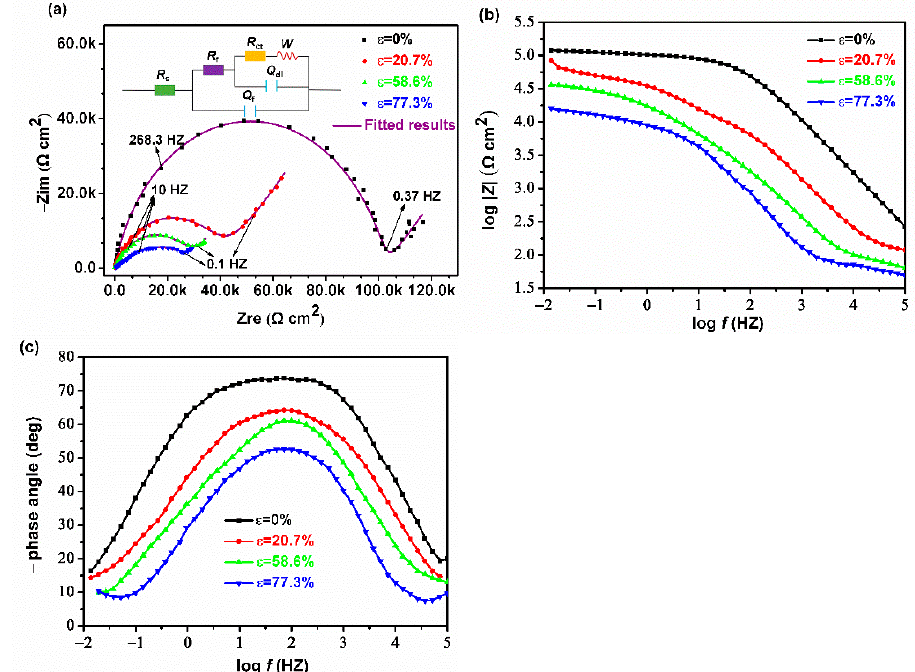
Figure 4. EIS results of Cu electrodes under different rolling reductions in the O/W emulsions: ( a ) Nyquist plot, ( b ) Bode absolute plots, and ( c ) Bode phase plots. Table 6. Parameters of the EIS results of different reduced Cu electrodes in O/W emulsions.